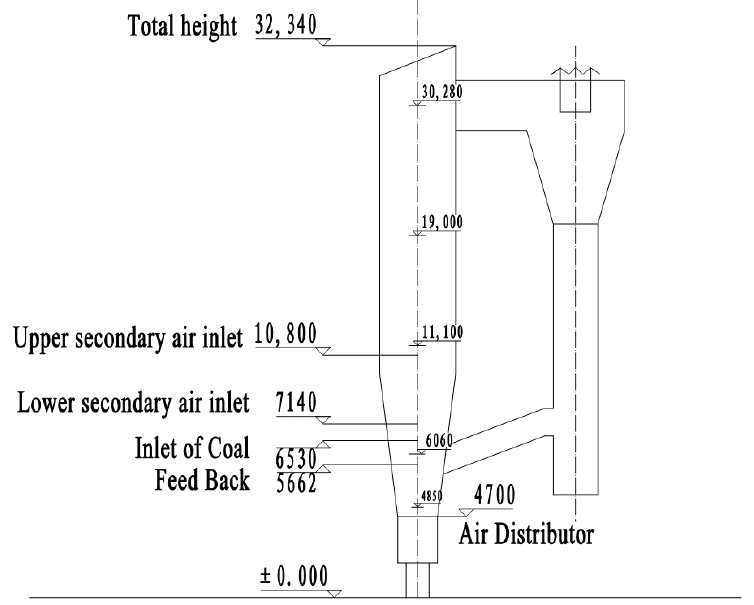
Figure 1. Structural schematic diagram of CFB boiler burning Fujian anthracite. Unit: